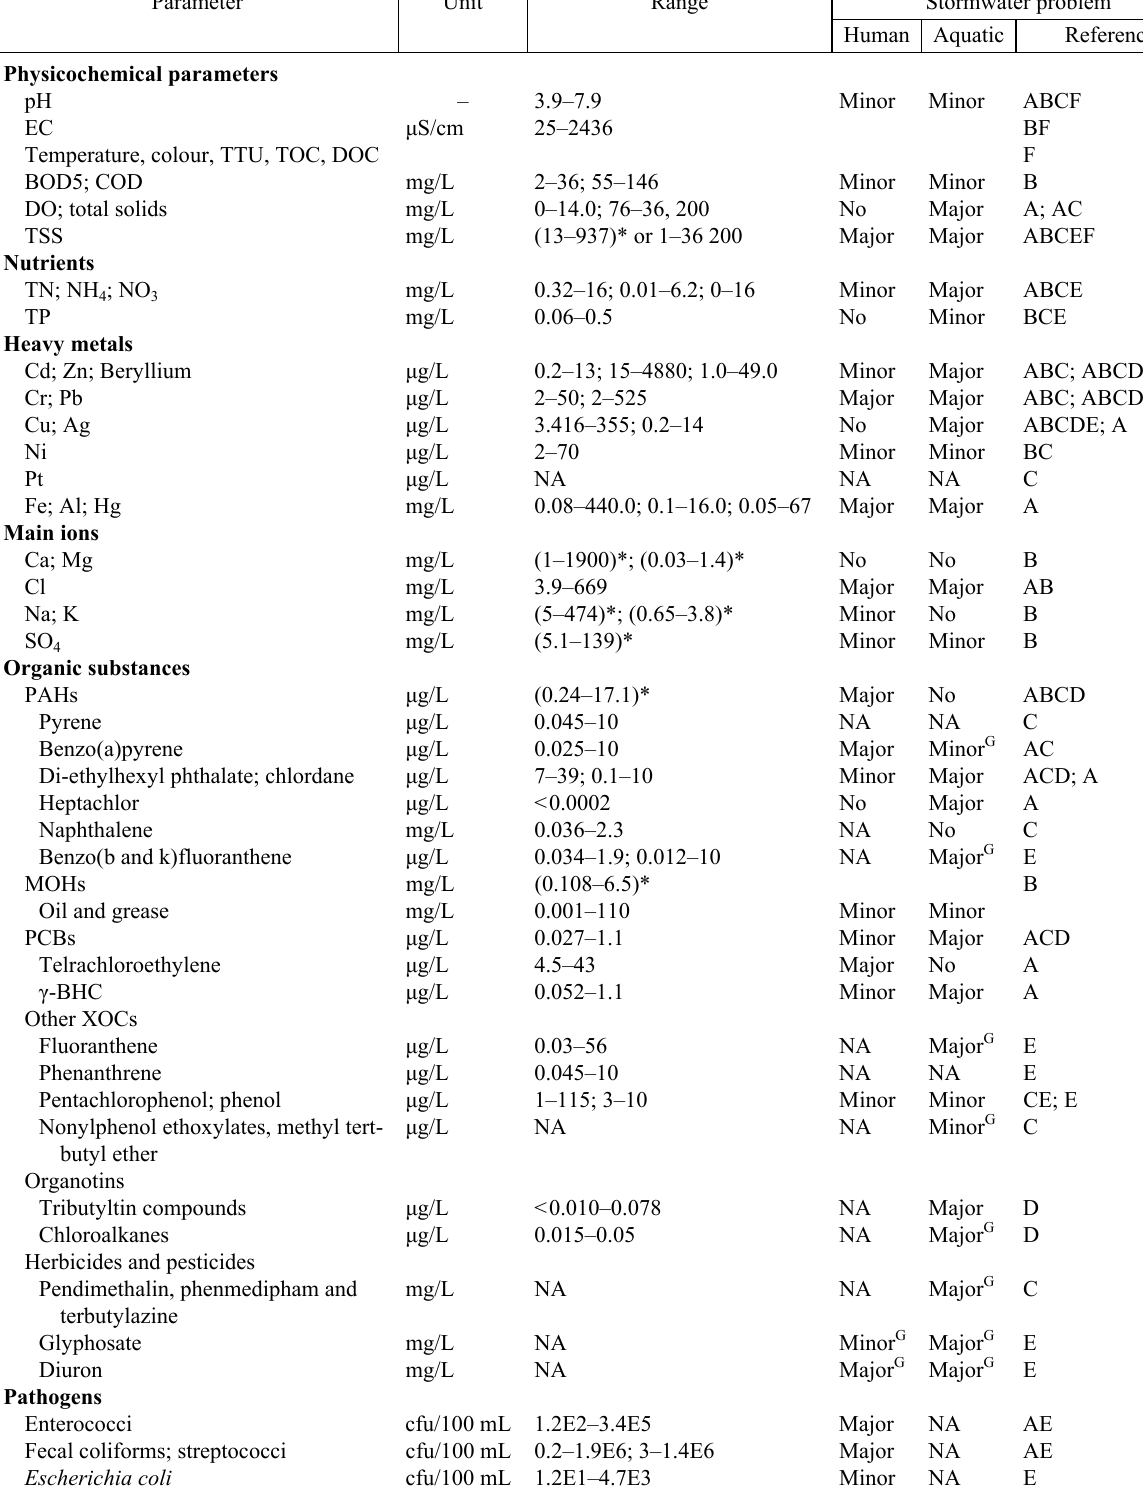
Table 2. General stormwater monitoring parameters including selected priority pollutants. NA, not